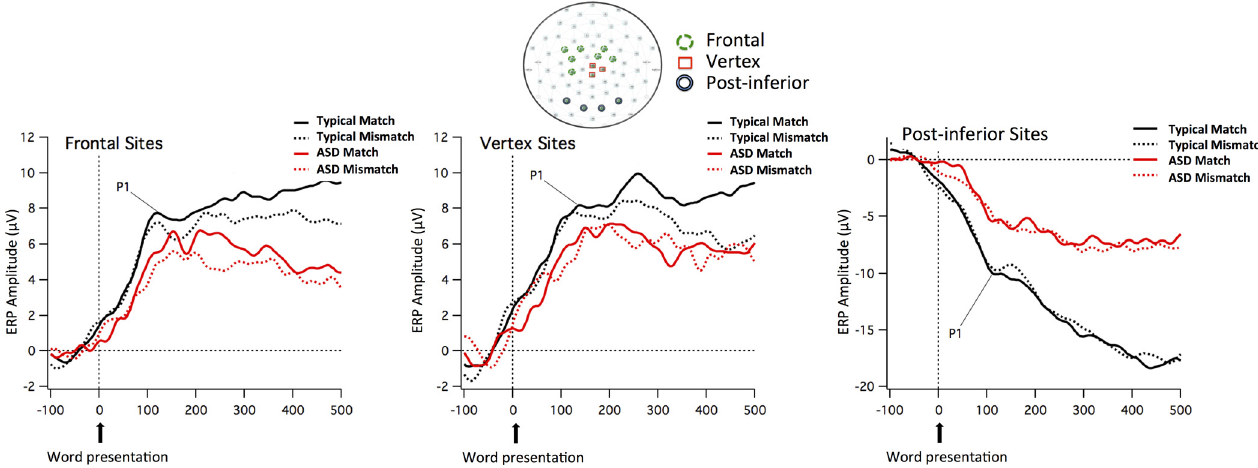
Fig 7. ERP waveforms of auditory evoked potentials. ERP waveforms time-locked to the word for the two groups (Neurotypical and ASD children) and the two conditions (Match and Mismatch) in the mean channels relative to the Frontal, Vertex, and Post-inferior sites included in the arrays. The sites that were used to create these arrays are displayed in the topographical map (Frontal sites in green, Vertex sites in red, and Post- inferior sites in black).